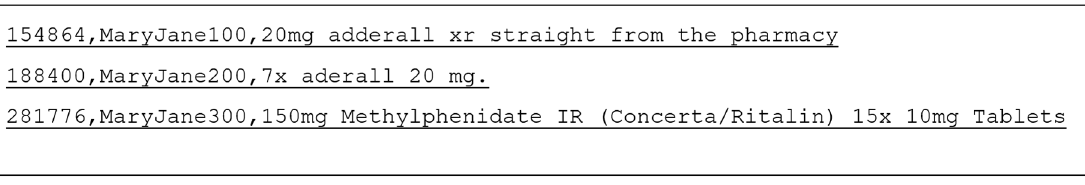
Figure 5. Example of Data from Retrieved Listings.